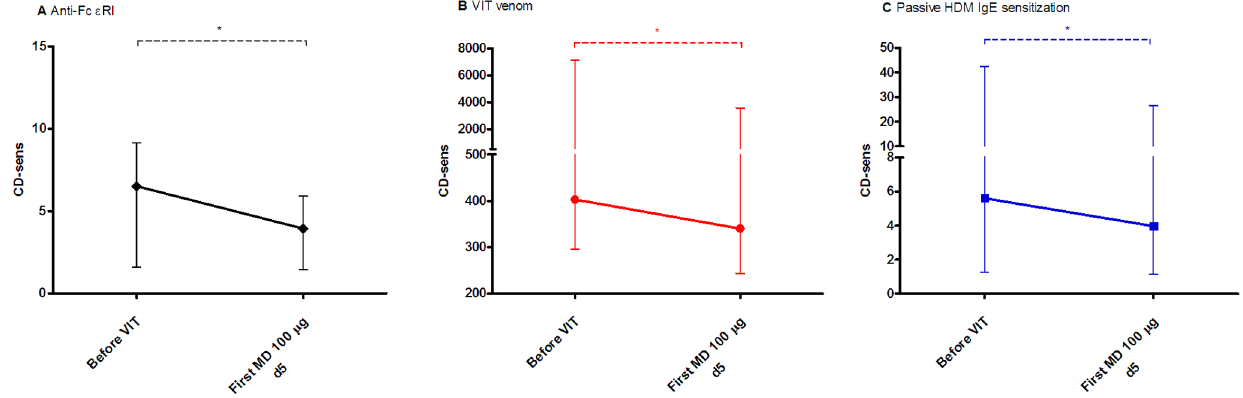
Figure 5. A–C. Passive IgE sensitization (CD-sens). CD-sens in in patients nos. 12–18 in A to anti-Fc e RI in B to VIT venom and in C after passive IgE sensitization of stripped basophils also to house dust mite stimulation before treatment and the first maintenance dose of ultra-rush VIT. Data are presented as median values with interquartile range. * P , .05.